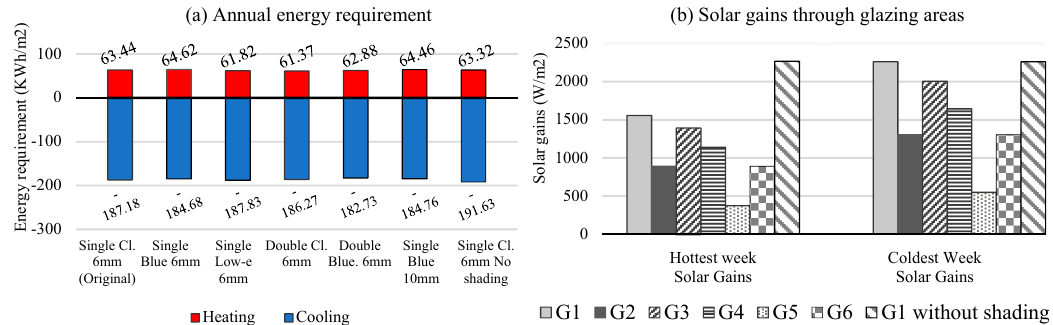
Figure 4. Annual Energy requirement ( a ) and solar gains ( b ) considering different glazing types.